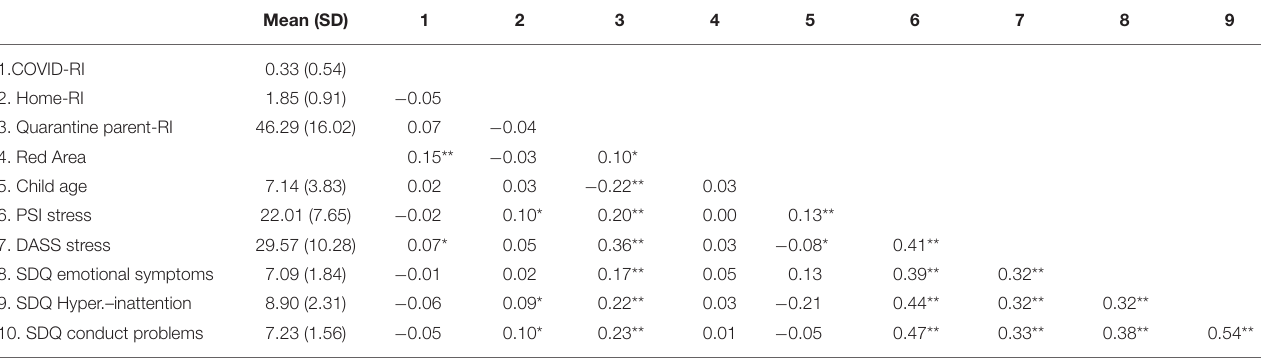
TABLE 1 | Descriptive and bivariate